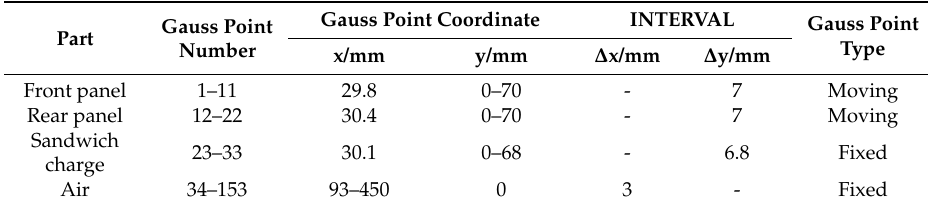
Table 2. The specific numbers and coordinates of Gauss points.